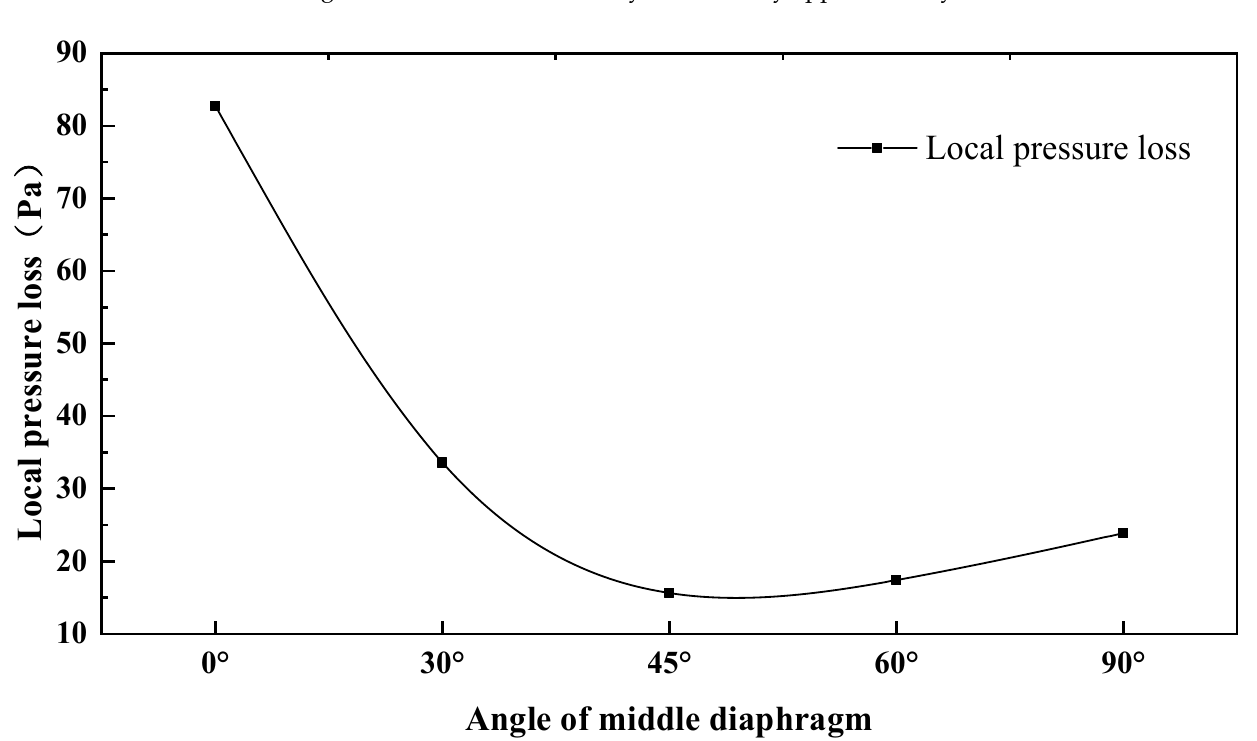
Figure 15. Airflow field distribution and differential pressure in different angles of the middle diaphragm.